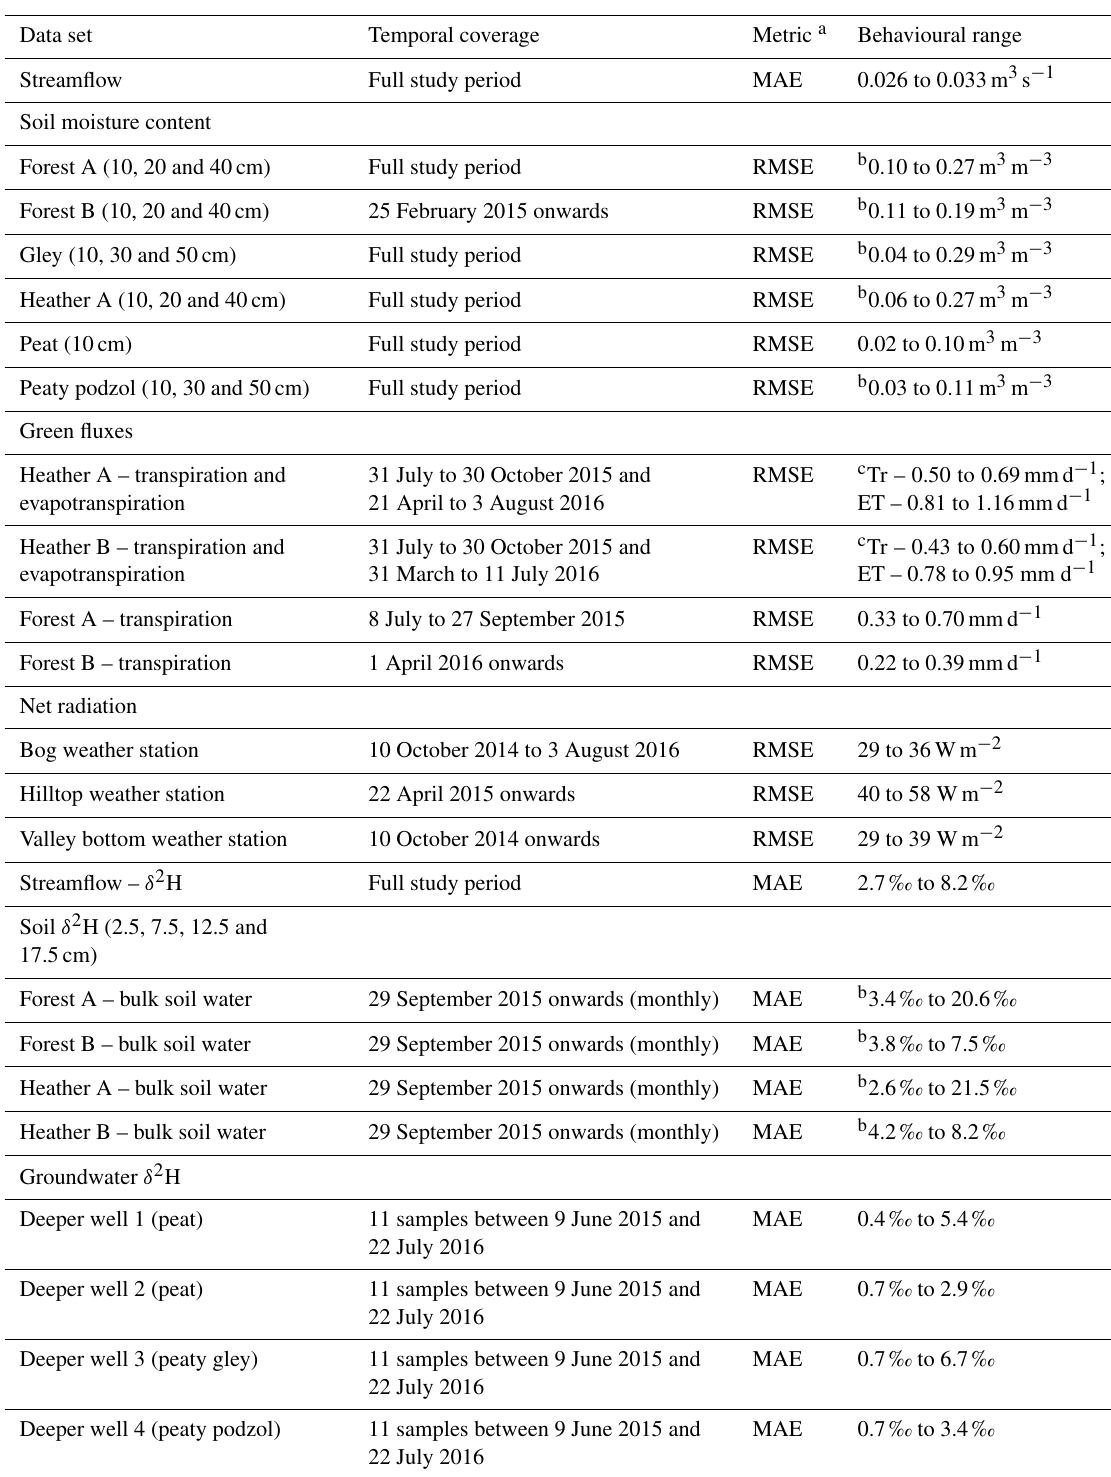
Table 2. Data sets used in the calibration of EcH 2 O-iso and their temporal coverage (full study period is 21 February 2013 to 8 August 2016). Performance metrics used to quantify the skill of the model in simulating each data set and the range of values achieved by the 30 behavioural model runs are also